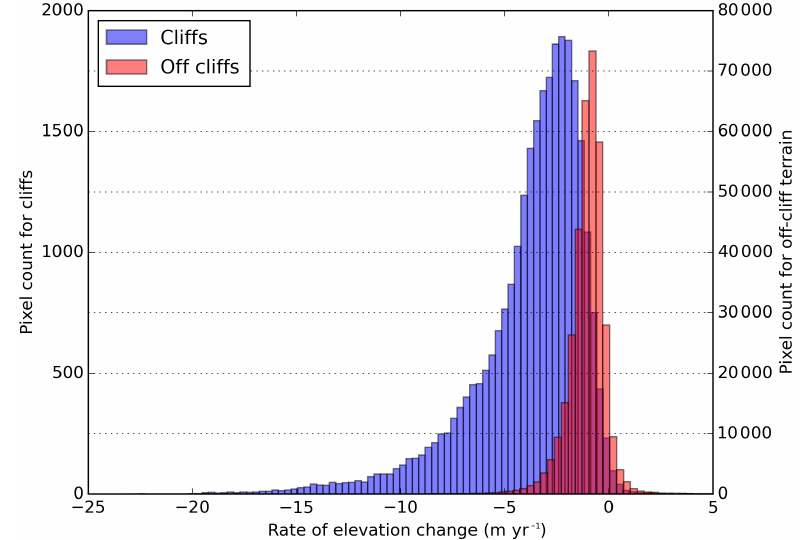
Figure 9. Rate of glacier surface elevation change for cliff and off-cliff terrain (Pléiades DEM difference November 2015–November 2016, corrected from flow). Note the strongly different y